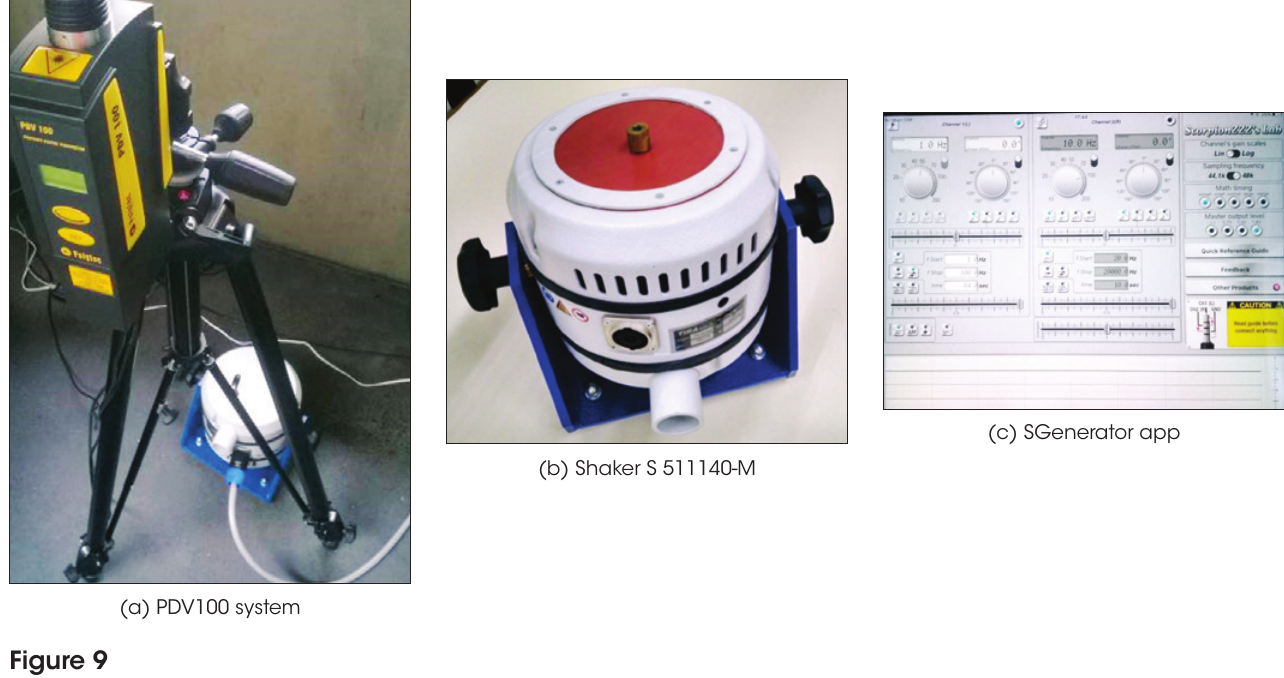
Modal analysis experimental test (Test